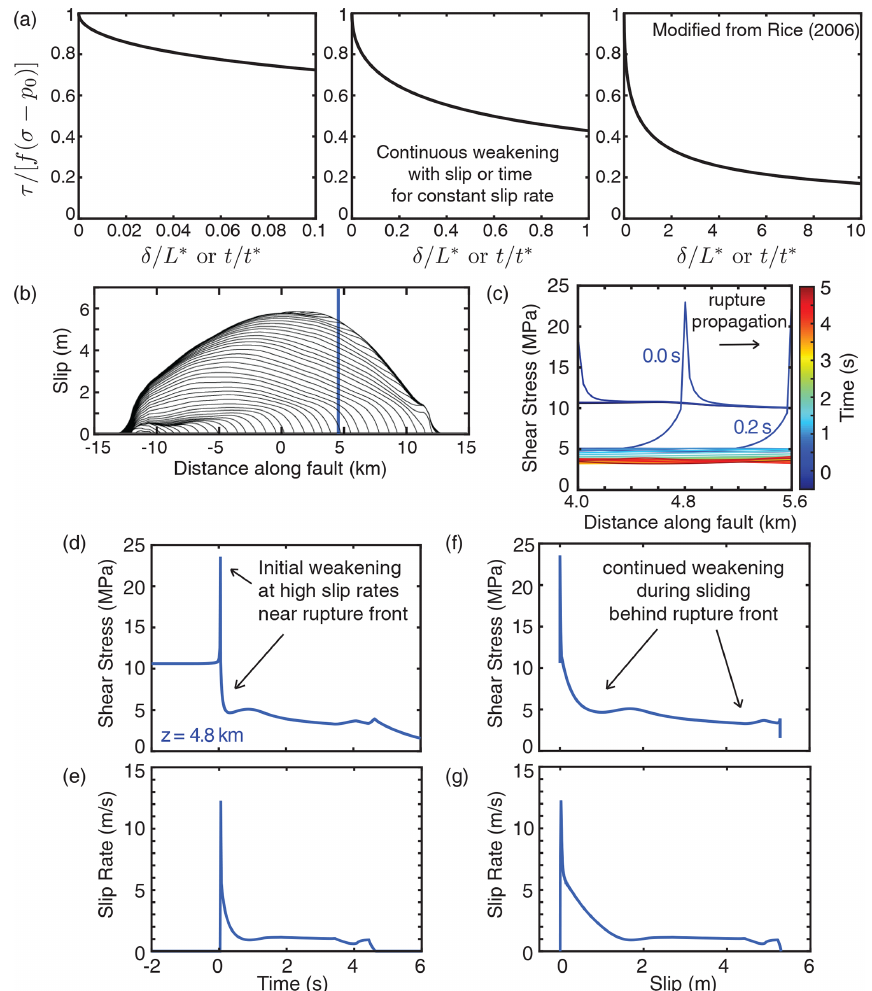
Figure 7. (a) Prediction of continuous weakening of shear resistance with slip or time due to the thermal pressurization of pore fluids during slip on a plane at constant slip rate V and constant friction coefficient f (Rice, 2006). (b) Evolution of slip during a dynamic rupture, slip contoured every 0.2s. (c) Evolution of shear stress localized around the point z = 4 . 8km within the rupture. The time window shown corresponds to the duration of sliding at seismic slip rates at z = 4 . 8m. (d, e) Evolution of local shear stress and slip rate with time at the point indicated by the blue line in panel (b) . (f ,g) Evolution of local shear stress and slip rate with slip at the same point. While qualitatively consistent with panel (a) in terms of the continued weakening with slip and time, the evolution of shear resistance during dynamic ruptures depends on the more complicated history of slip rate, which varies throughout the rupture process. Most of the initial local weakening occurs at slip rates higher than 1m/s as the rupture front passes by, followed by more gradual weakening behind the rupture front at lower, although still seismic, slip